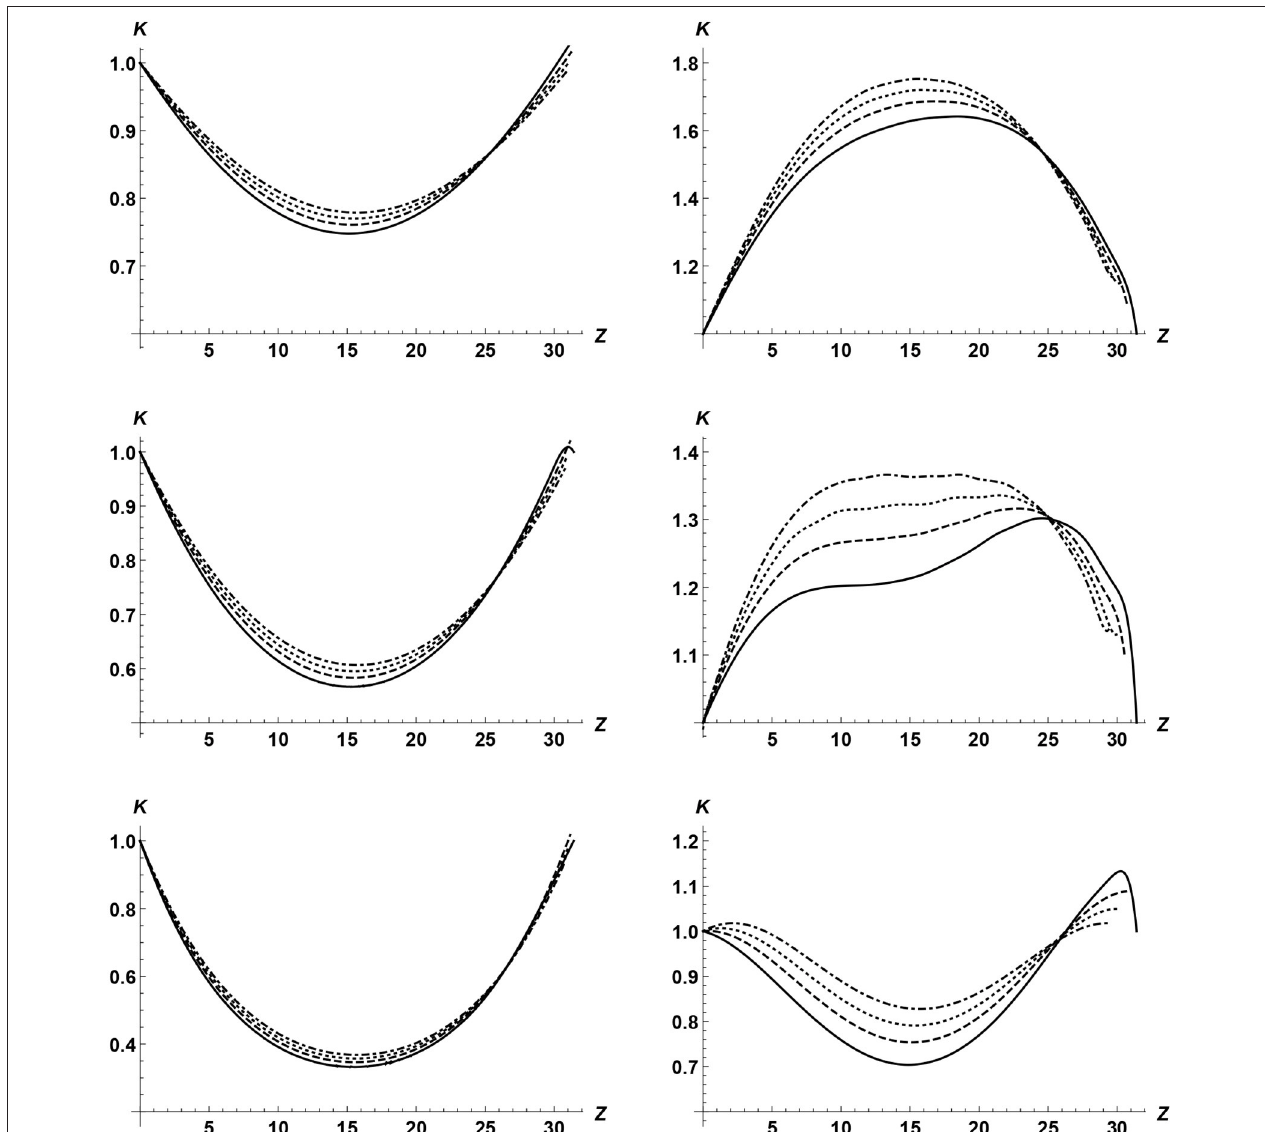
t end . The left panels correspond to λ =